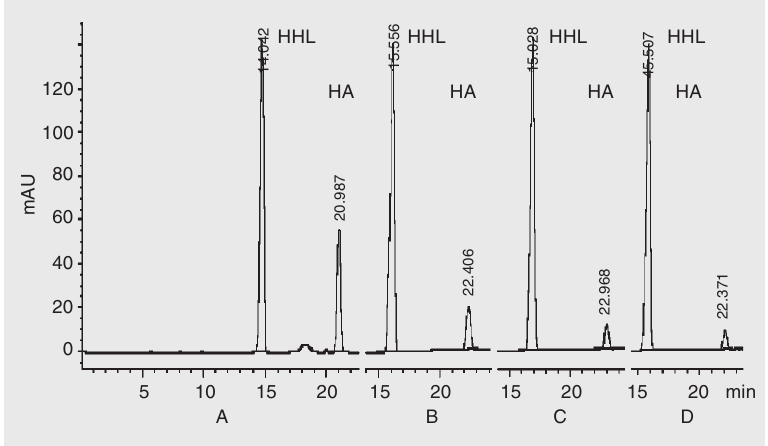
Figure 1. Capillary electrophoresis separation of the angiotensin I-converting enzyme reaction mixture incubated without whey protein hydrolysate (WPH; A) and with WPH at concentrations of 0.25 mg/mL (B), 0.5 mg/mL (C), and 1.0 mg/mL (D; N = 8 for each concentration). HHL = hippuryl-His-Leu; HA = hippuric